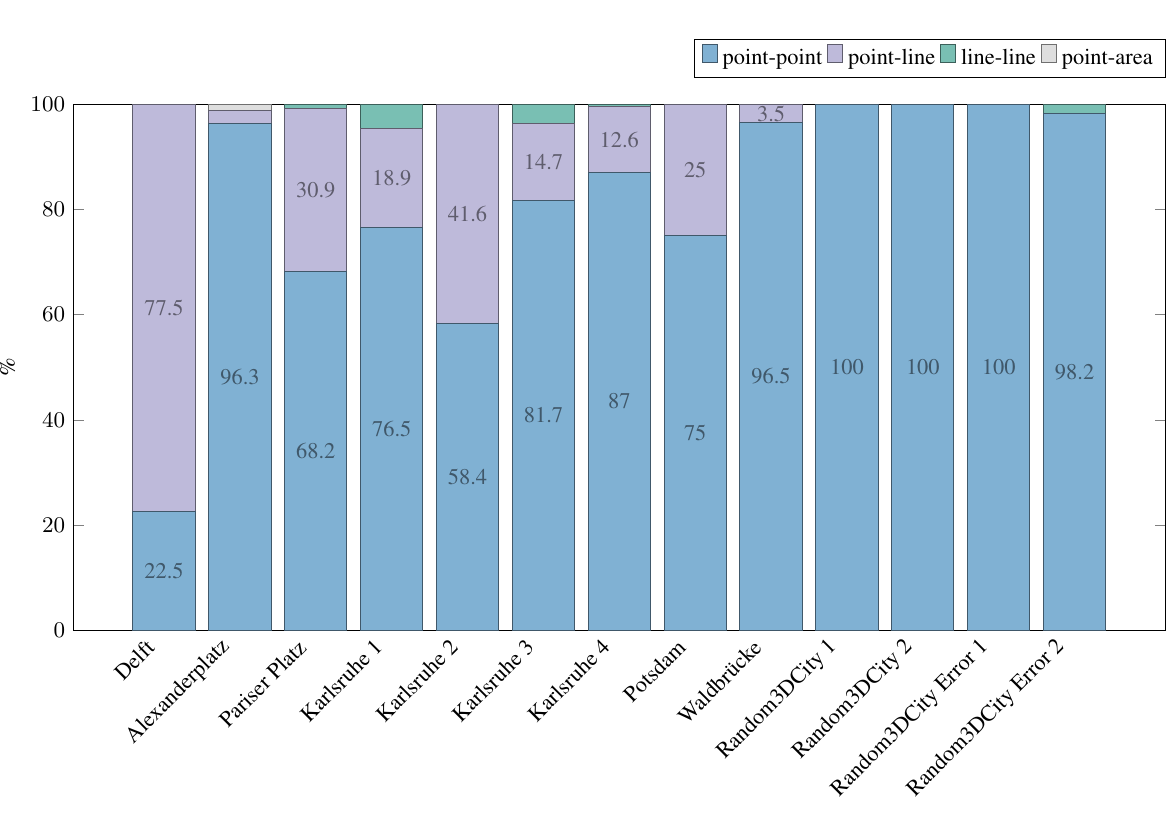
Figure 5. Intersection matrices when intersection is a